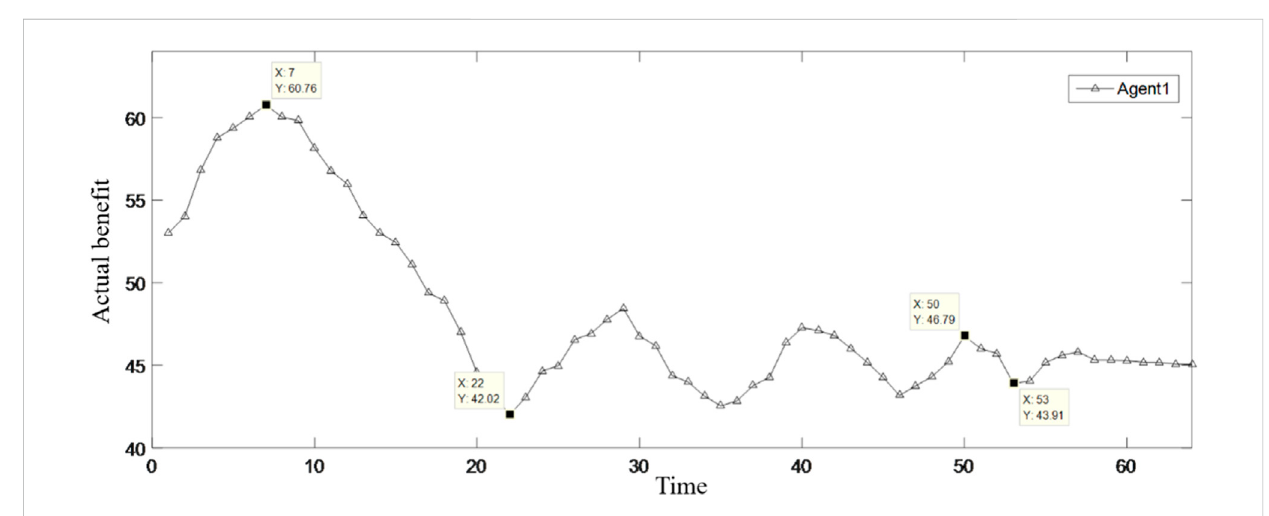
FIGURE 3 Changes in the bene fi ts of Agent